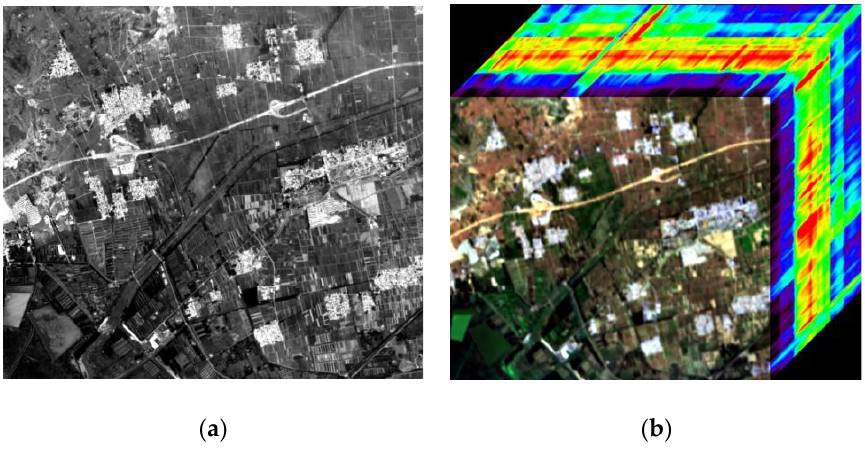
Figure 3. Preprocessed image data: ( a ) GF-1 Band 4 ( b ) GF-5 image.